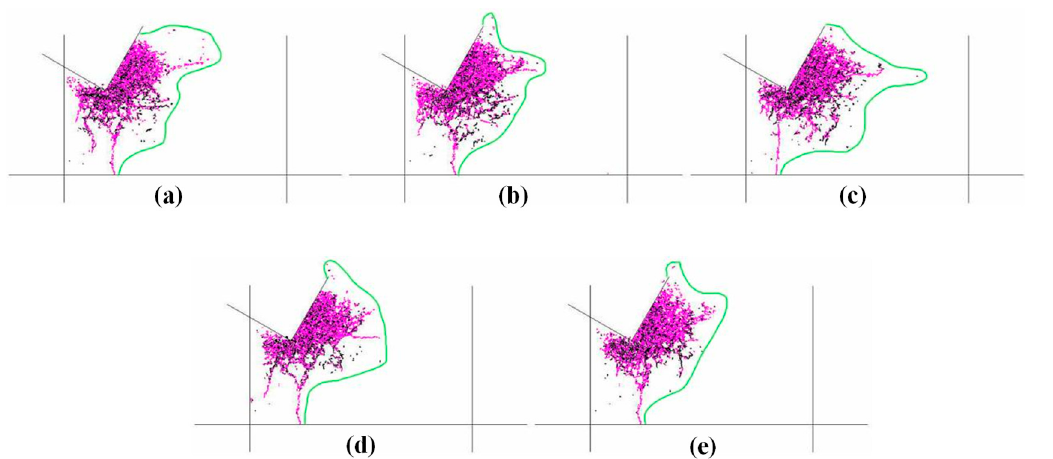
Figure 8. Schematic diagram of crack distribution of specimens with different bedding dips: ( a ) 0°; ( b ) 30°; ( c ) 45°; ( d ) 60°; ( e ) 90°. (Purple represents shear crack, black represents tensile crack, and the range of green curve envelope represents crack growth area.)